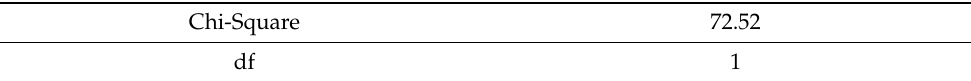
Table 5. Chi-square test value for the variables “mass media” and “dual career.”